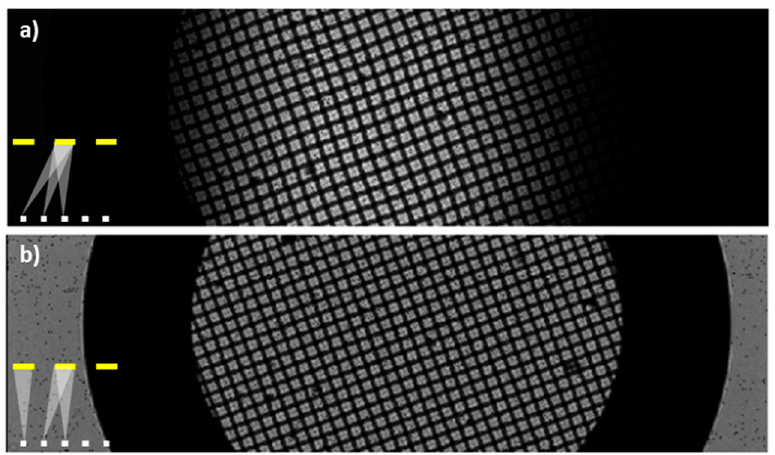
Figure 3. Squared TEM grid placed in contact with source 1 and viewed with two configurations for the scanned optical microscope: in ( a ) the pixel at the camera center records statically the transmitted light for all the LEDs in the microdisplay, while in ( b ) the light from each activated LED is recorded by the pixel located just in front of it (dynamic measurement). The insets at bottom left show the sketches of the respective operation